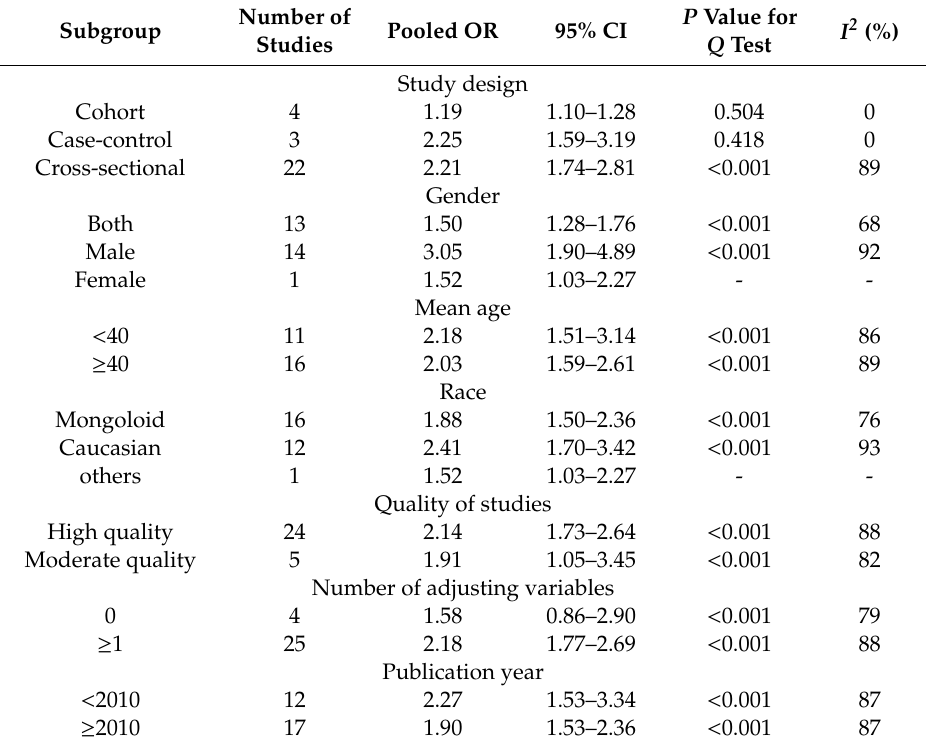
Table 2. Results of subgroup analysis between current smokers and NIHL